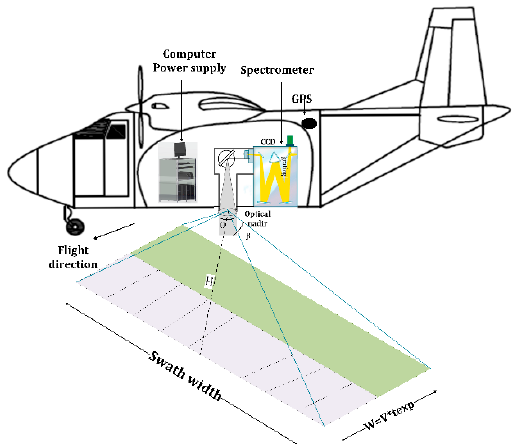
Figure 1. Airborne infrared remote sensing spectrometer (Air-IRSS), and schematic illustration showing the general measurement principle of Air-IRSS. The IFOV across the flight track θ , and the corresponding ground-projected instantaneous width named swath width; the IFOV along the flight track β , and the corresponding ground-projected instantaneous width named W, which can be calculated by flight speed V and flight exposure time t exp , described as W = V × t exp .